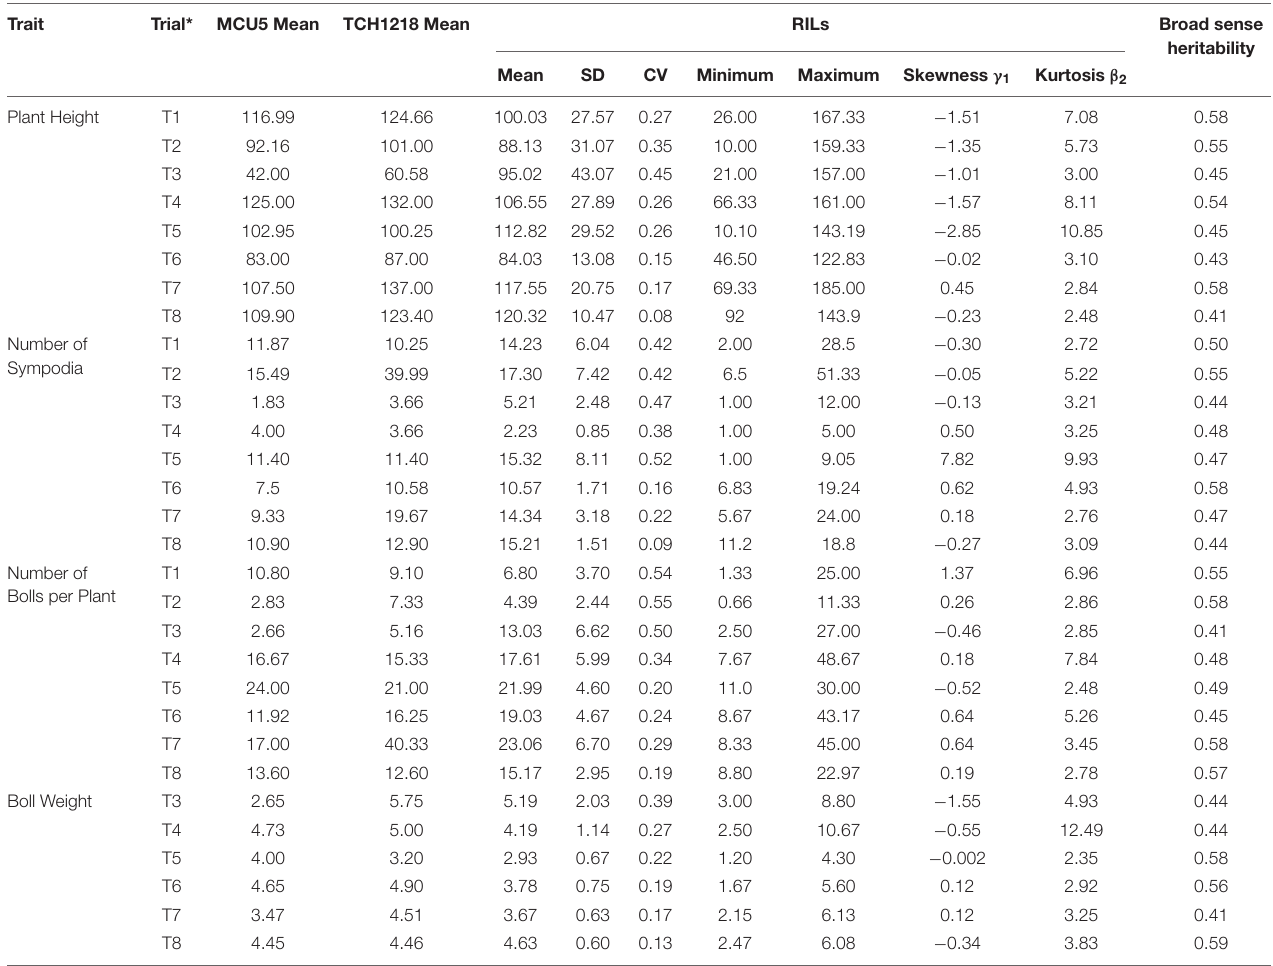
TABLE 2 | Phenotypic variation and descriptive statistical analysis of data on yield traits obtained from RILs derived from MCU5 and TCH1218 across the environments and seasons.